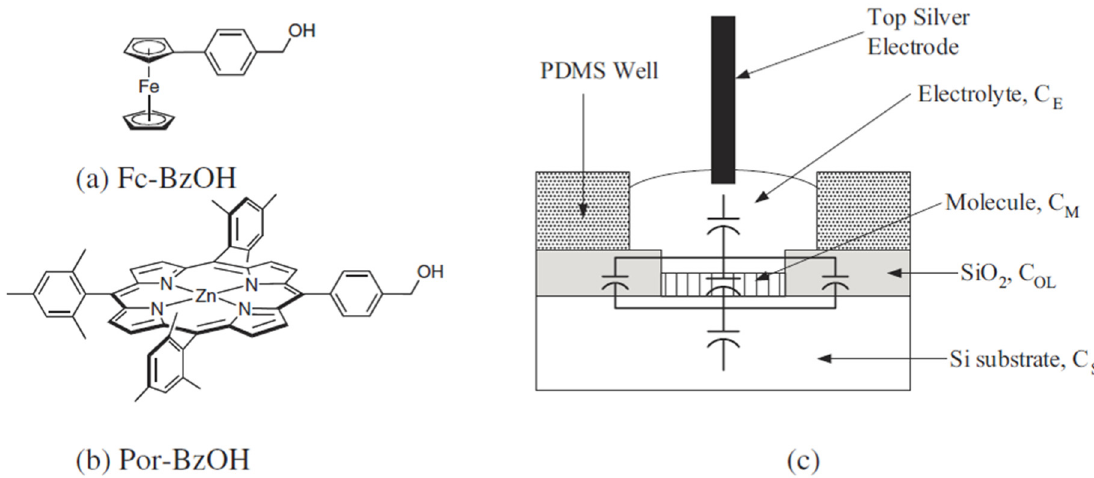
Figure 4. Structure of redox-active molecules ( a ) Fc-BzOH and ( b ) Por-BzOH for memory applications; ( c ) schematic of an electrolyte-molecule-Si capacitor with a simplified equivalent circuit. Reproduced with permission from [36], © John Wiley and Sons, 2004.